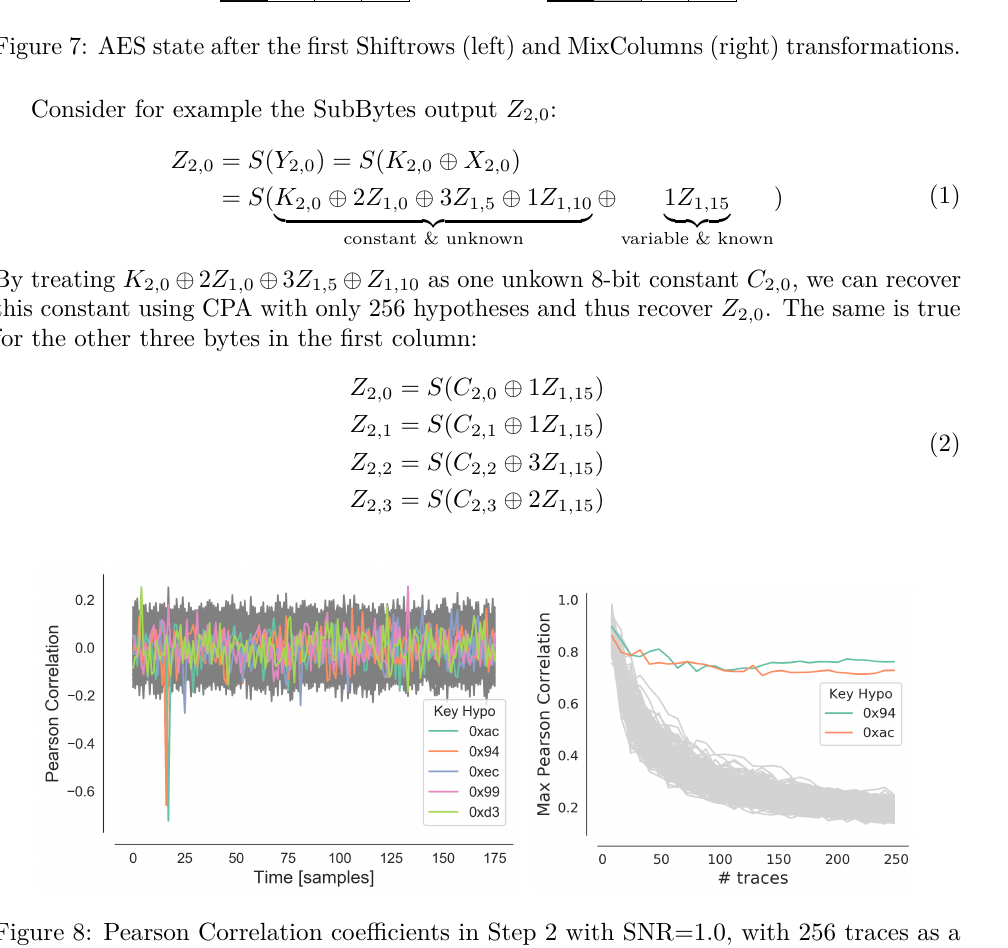
Figure 8: Pearson Correlation coefficients in Step 2 with SNR=1.0, with 256 traces as a function of the time samples (left) and their maximum as a function of the number of traces